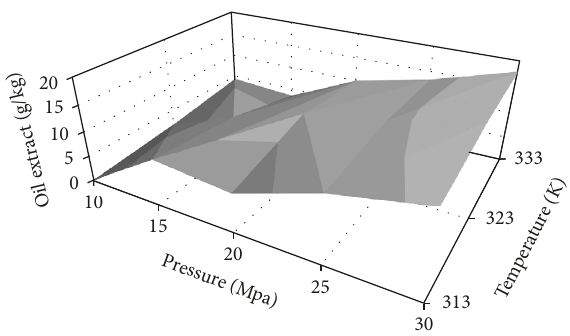
Figure 2: Effect of temperature and pressure on total oily amaranth extract [g/kg] obtained by SCFE from amaranth puffed